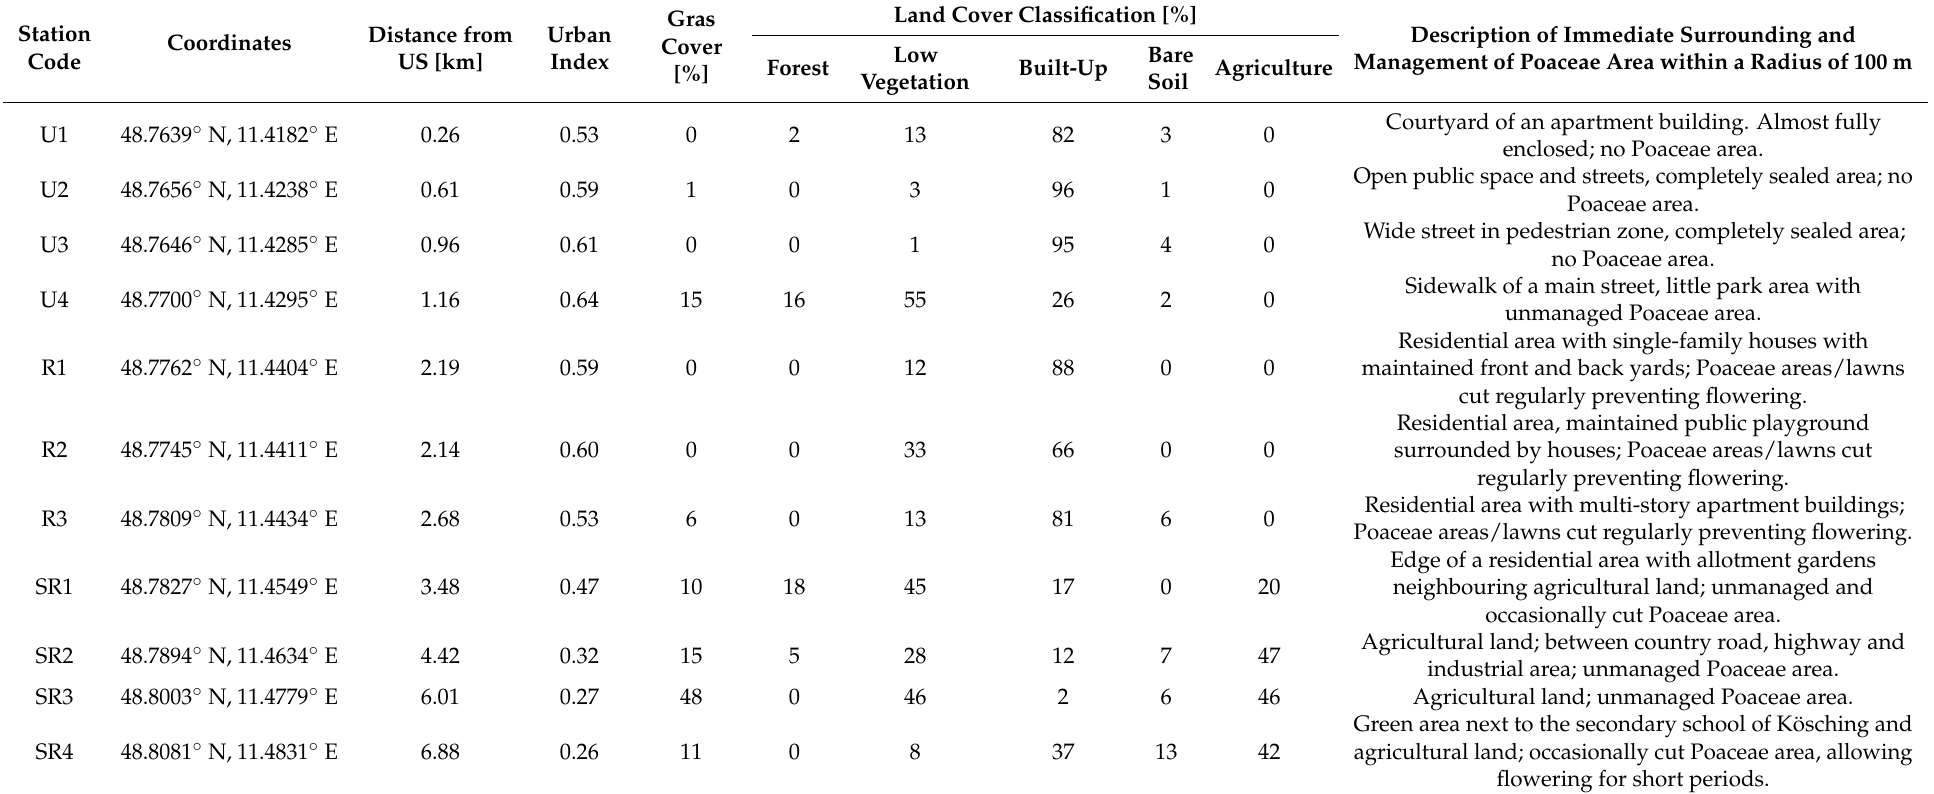
Table 2. Sampling locations and surroundings of PVAS. Grass cover [46] and land cover [45] within 100 m of the traps (see methodology section for calculation). Land cover class “water” is not listed as its values equalled 0 for all sampling locations. Classification of station code: U = urban, R = residential, SR =